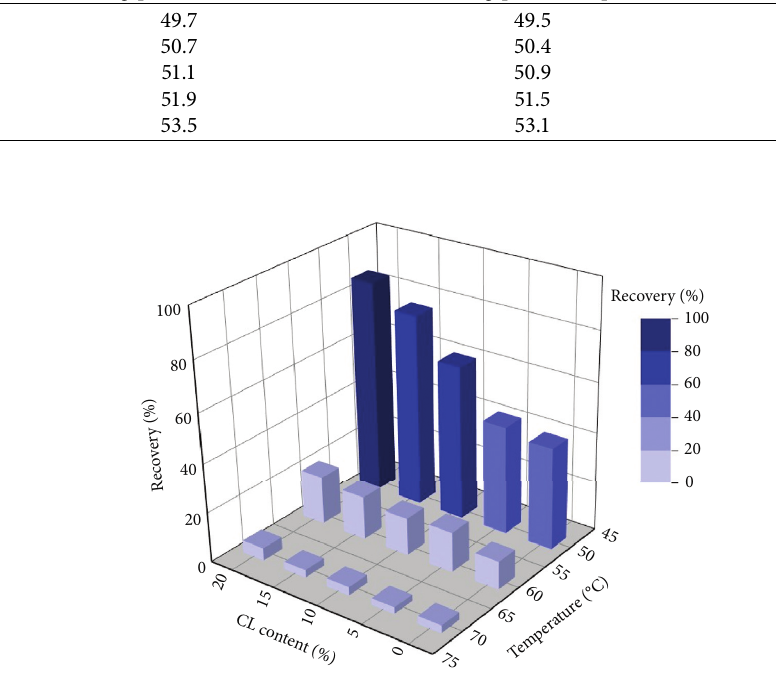
Figure 7: Variations in the percent recovery R at different test conditions under 0.1 kPa stress level.